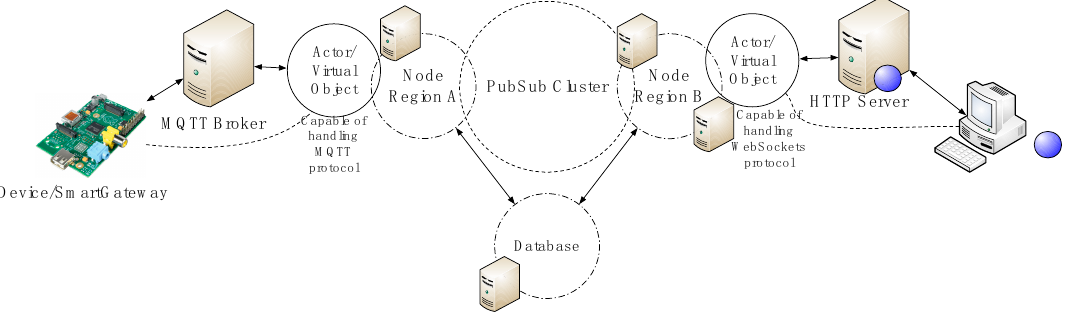
Figure 6. System design and architecture.